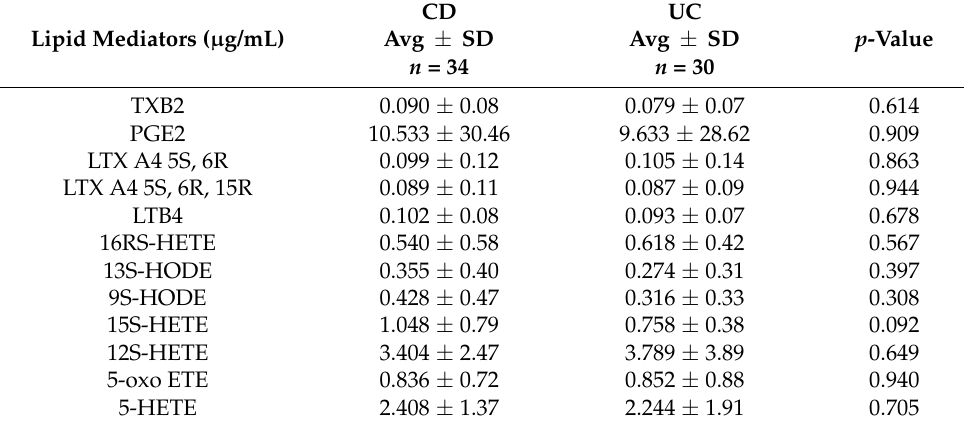
Table 3. Characteristics of selected lipid mediators in CD and UC groups.